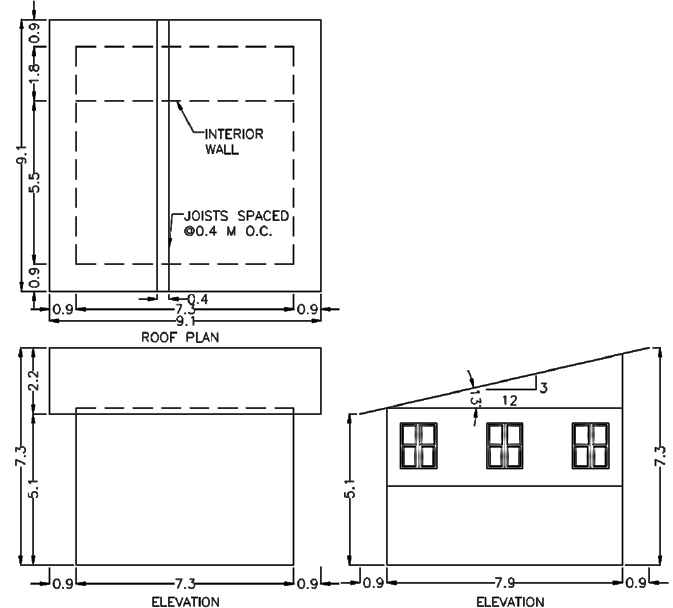
Figure 3. Building plan and elevation (All dimensions are given in